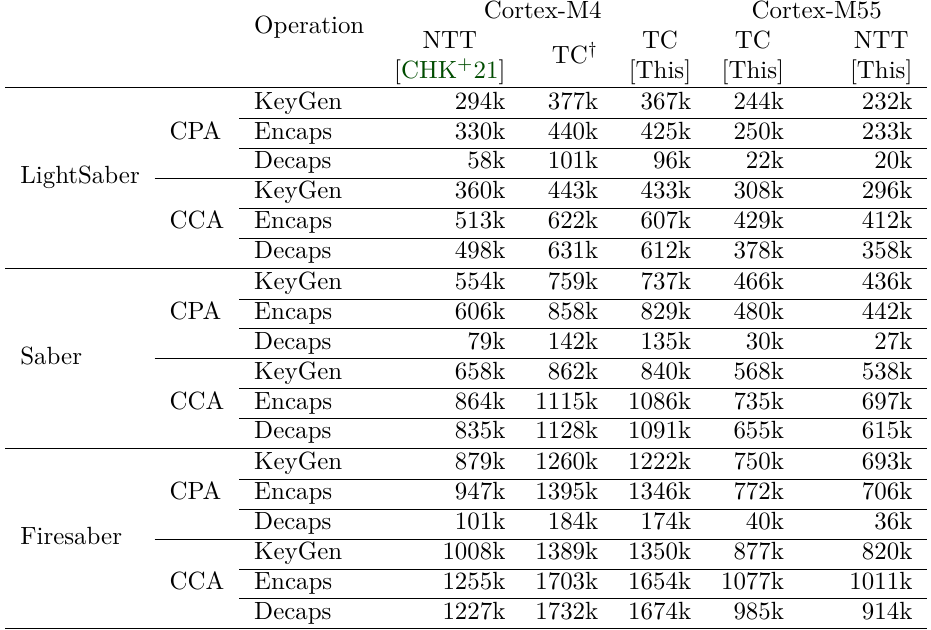
Table 2 Comparison of Toom-Cook and NTT-based implementations of Ind-CPA and Ind-CCA versions of the NIST PQC finalist Saber. SW-based hashing waters down optimizations for polynomial multiplication, but is expected to be HW-accelerated in practice, see Section 6.6. Numbers are for the SHA3-based Saber, not the 90s